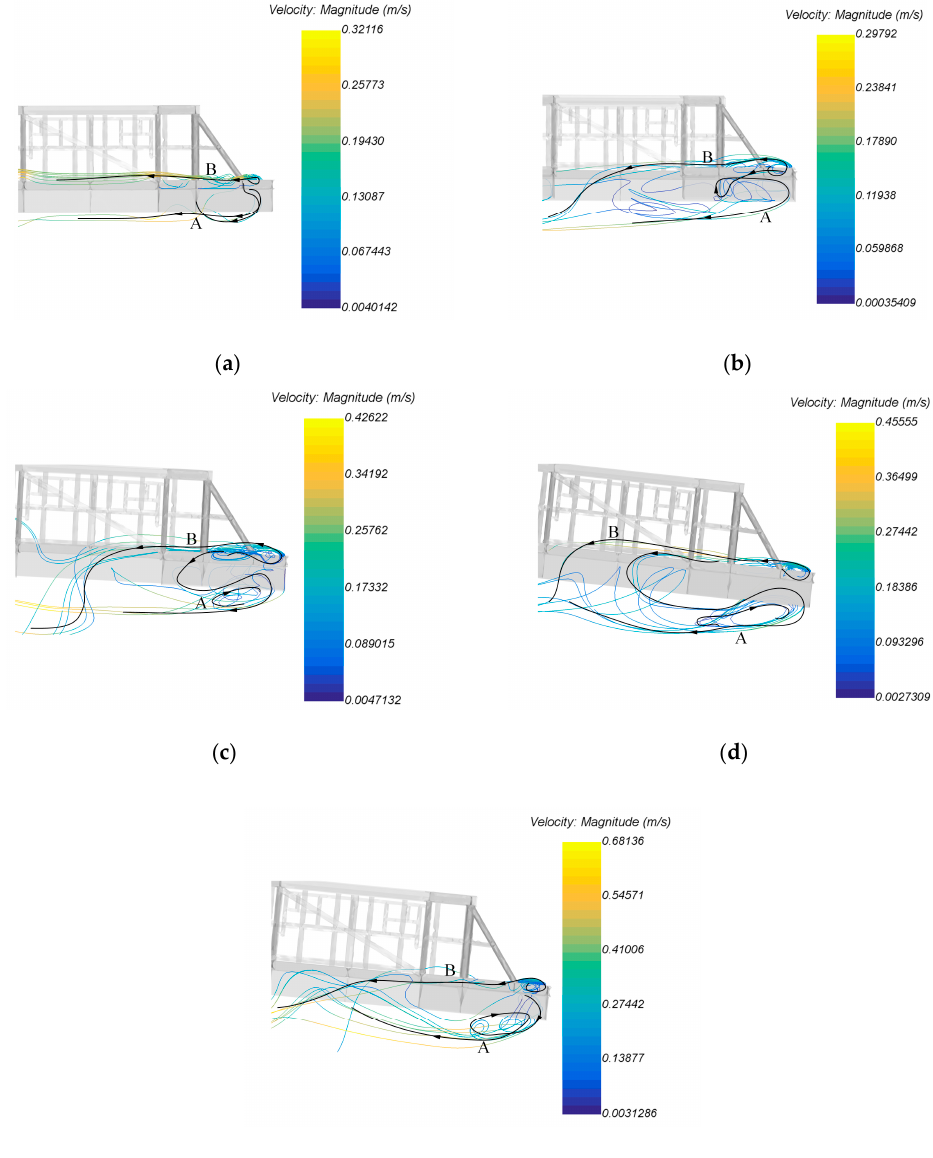
Figure 16. Flow patterns in the inlet section for X-direction towing cases: ( a ) Flow patterns in Case 1, ( b ) Flow patterns in Case 2, ( c ) Flow patterns in Case 3, ( d ) Flow patterns in Case 4, ( e ) Flow patterns in Case 5.